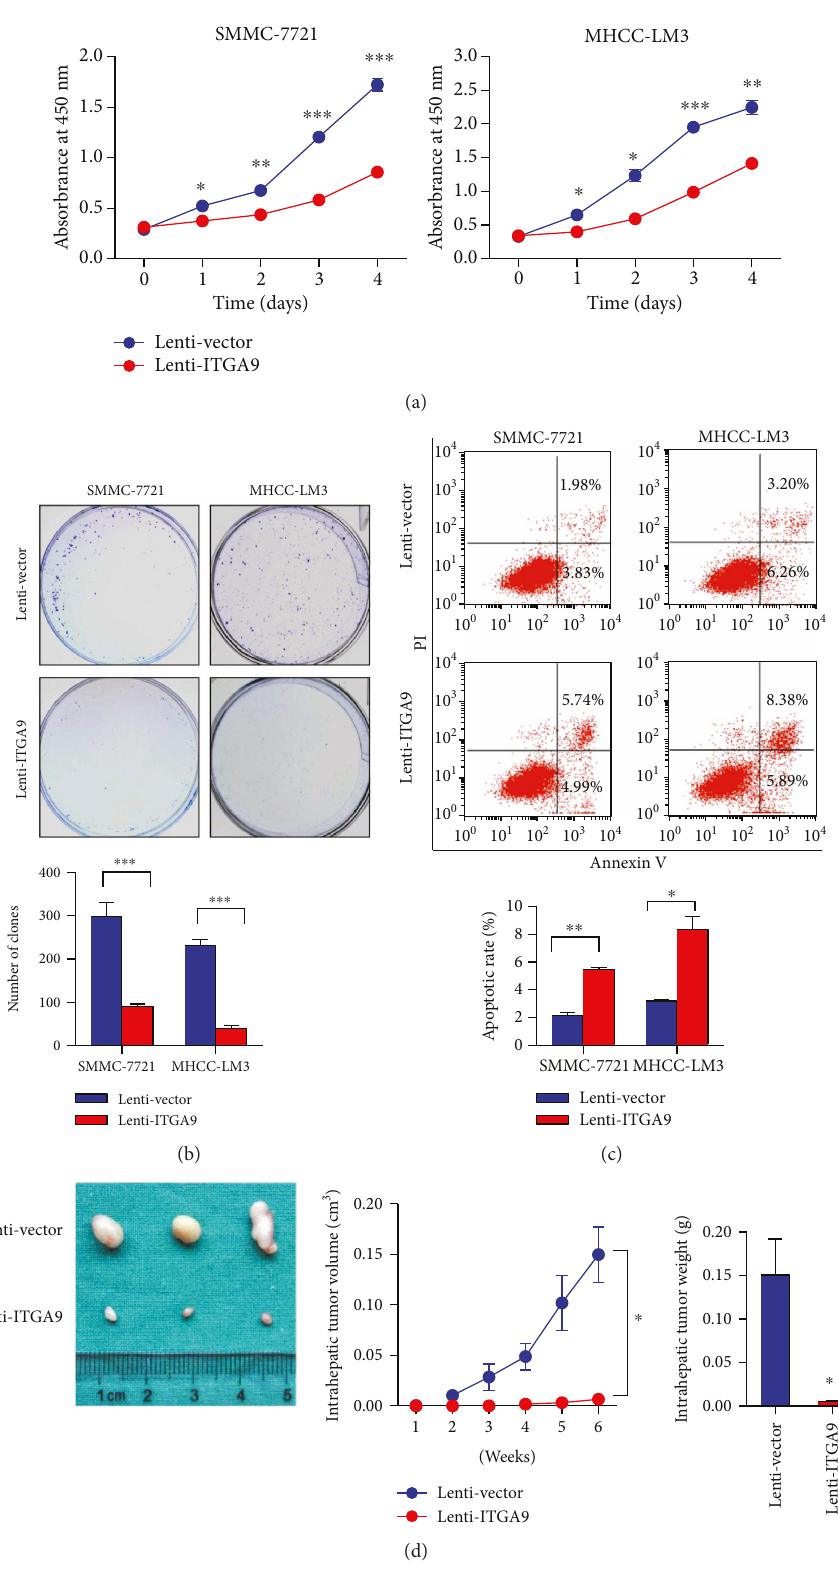
Figure 3: ITGA9 prevents HCC growth in vitro and in vivo . (a) Analysis of HCC cell viability with ITGA9 overexpression or control by CCK8. n = 6 . (b) Analysis of HCC cell proliferation with ITGA9 overexpression or control by colony formation. (c) Annexin V/PI staining was used to measure apoptosis in HCC cells. Numbers indicated the percentage of each quadrant. n = 3 . (d) In vivo orthotopic growth of ITGA9-overexpressed versus control HCC cells. n = 6 . Values are means ± SEM. ∗ P < 0 05 , ∗∗ P < 0 01 , and ∗∗∗ P < 0 001